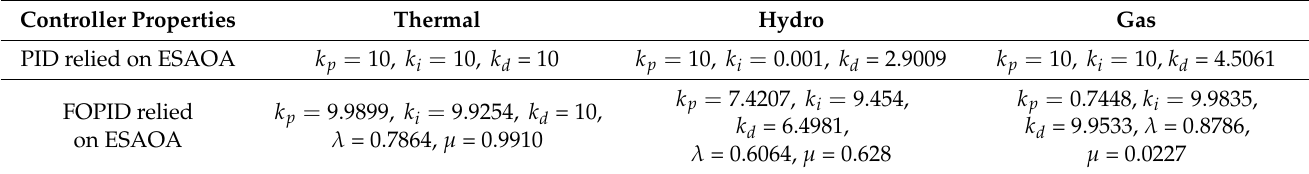
Table 8. The optimal controllers’ values for scenario B.